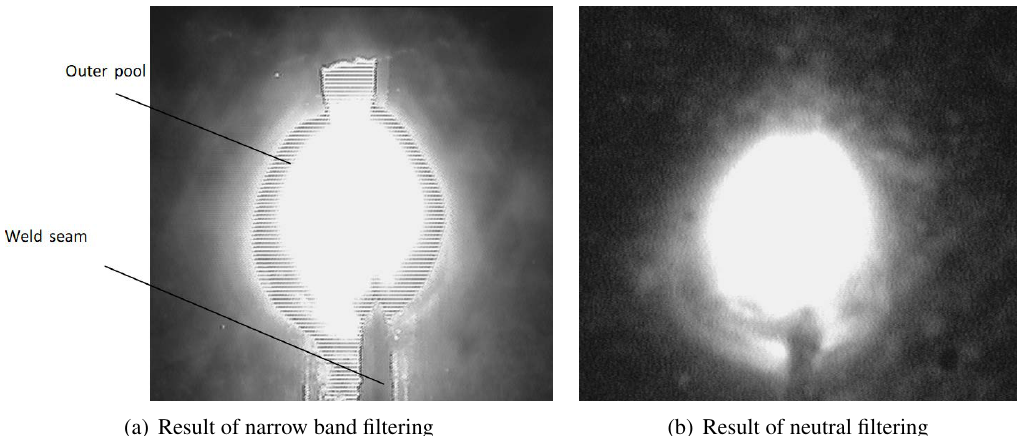
Fig. 4 Results of narrow band filtering and neutral